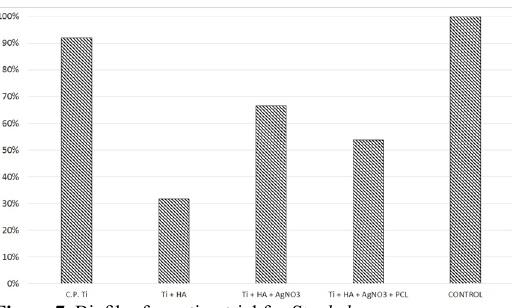
Figure 6. Bacterial viability trial for Staphylococcus aureus .